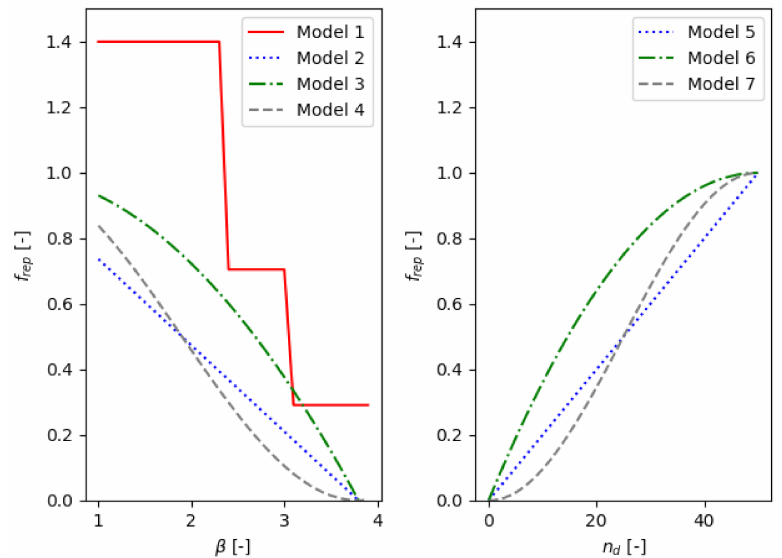
Figure 9. Different assumed cost